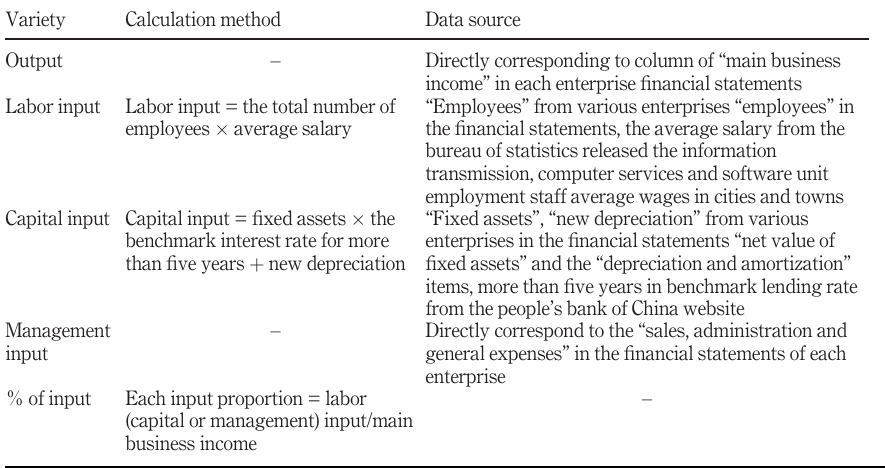
Table I. Variable